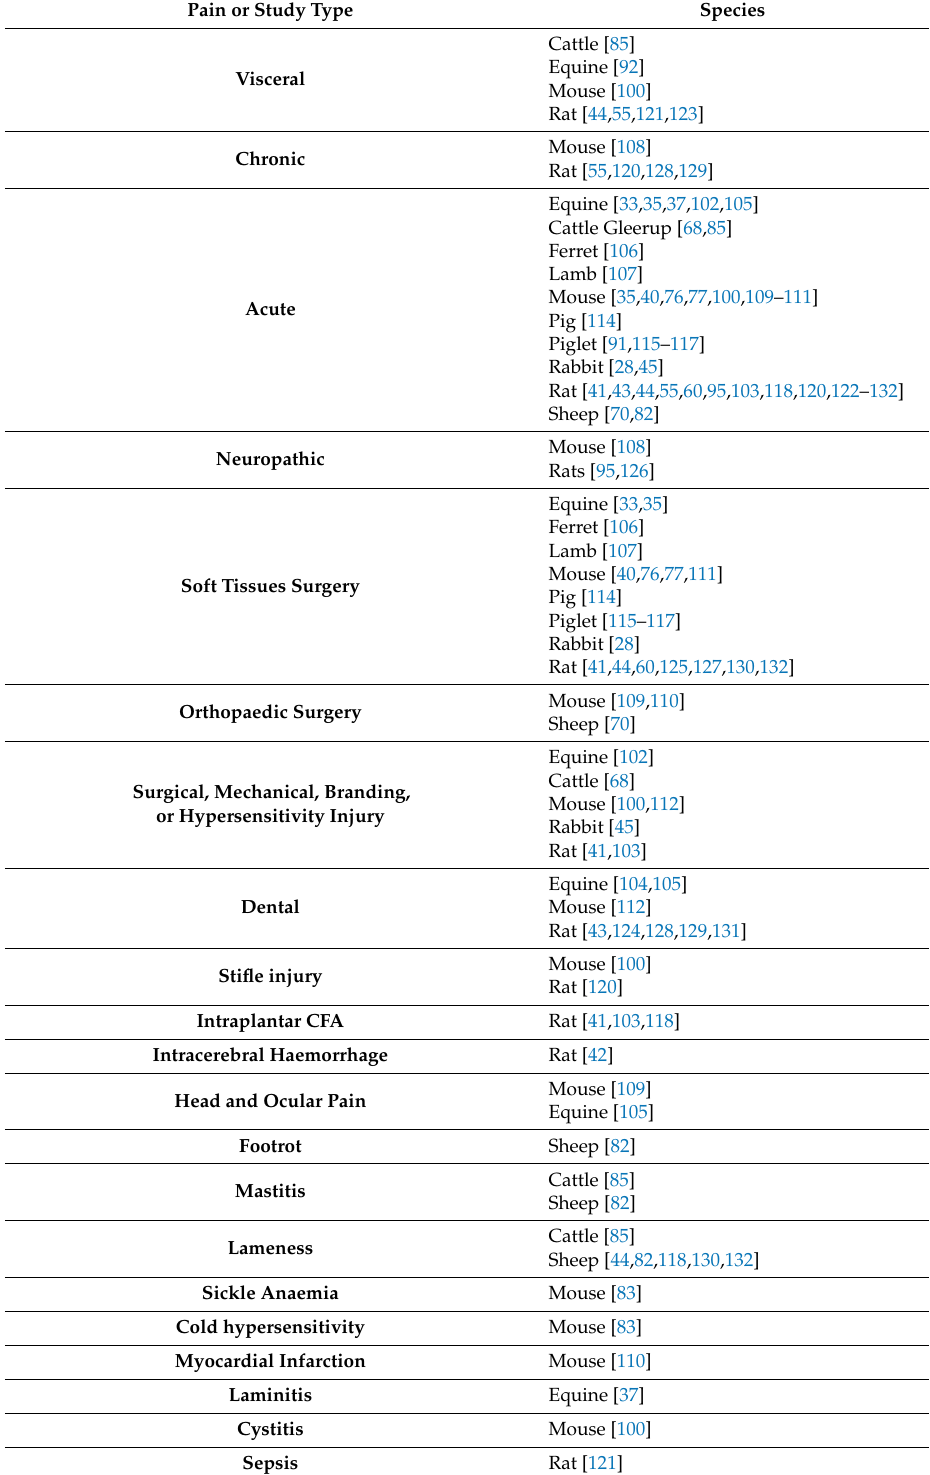
Table 4. Grimace Scales by Experimental Study or Pain